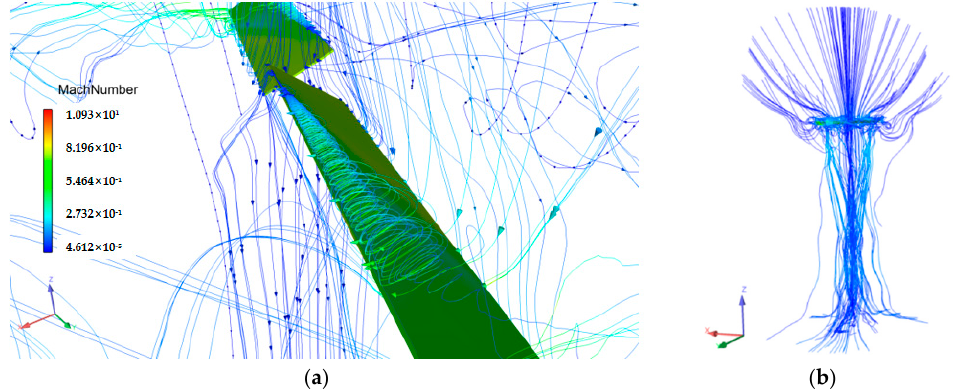
Figure 9. Streamline of case 3. ( a ) streamline around the rotor. ( b ) streamline of the whole flow filed.